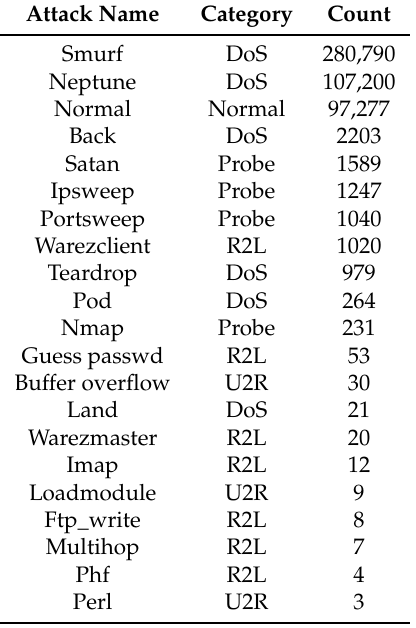
Table 3. Number of attacks used in this research for KDD99.